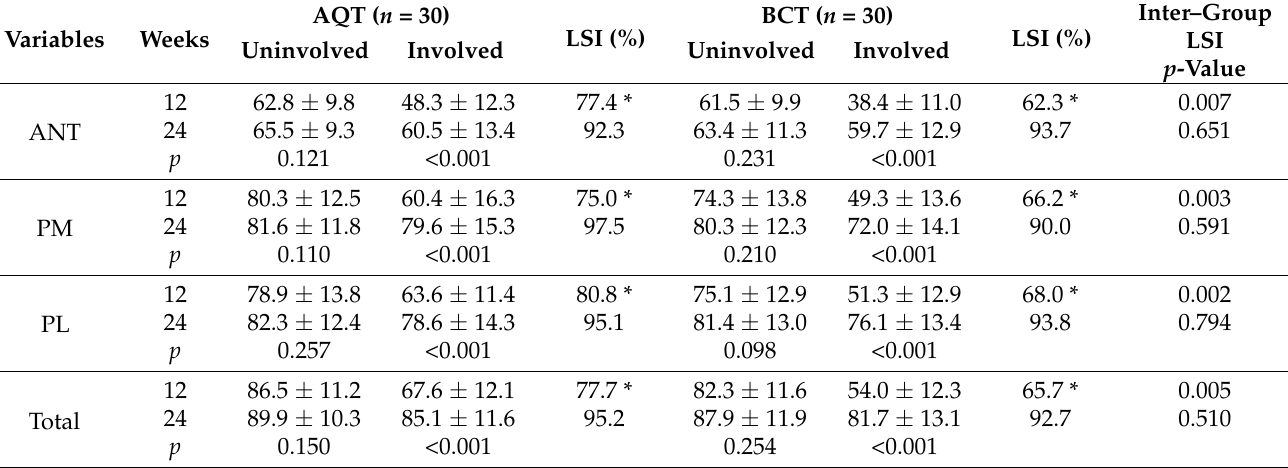
Table 6. Y-balance test according to group and